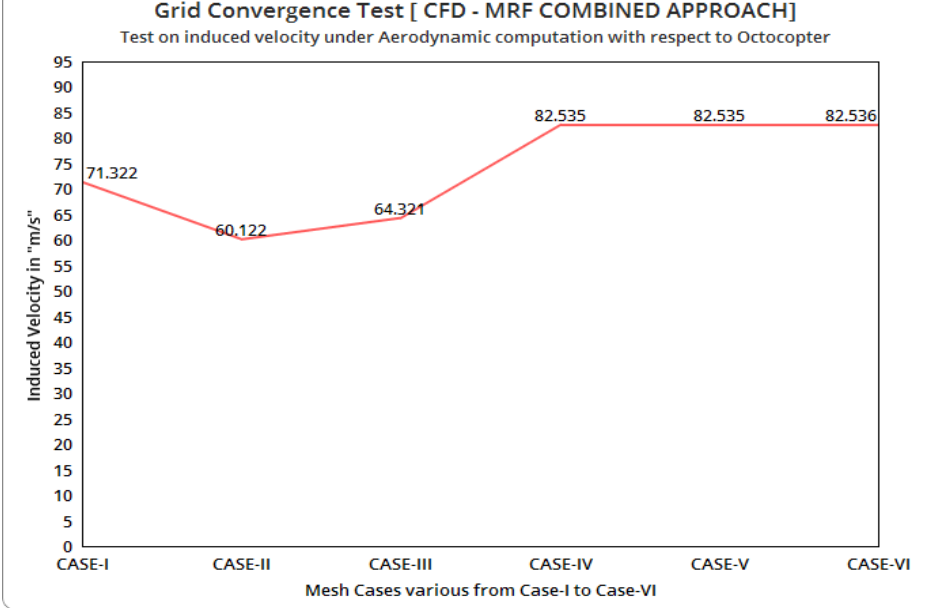
Figure 18. Grid-convergence results for aerodynamic analysis.